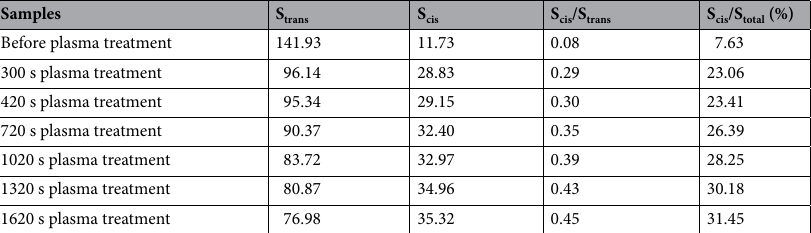
Table 3. The amounts of DR1 dye isomeric species and their ratios calculated from fitted double peaks before and after plasma treatment at different time intervals for dye-doped PMMA with extra surface dye. S trans area under the fitted peak 1, S cis area under the right fitted peak 2, S total area under the cumulative fit peak.